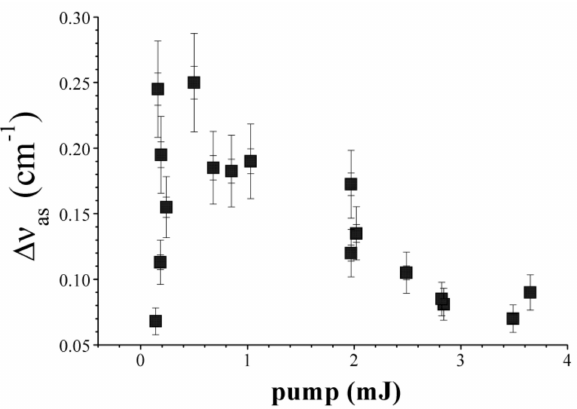
Figure 11. Anti-Stokes 2PA SRMS spectral shifts vs. the pump pulse energy measured in Ag nanoparticle colloid solution (0.003 M) under 100 ps 0.532 µ m laser